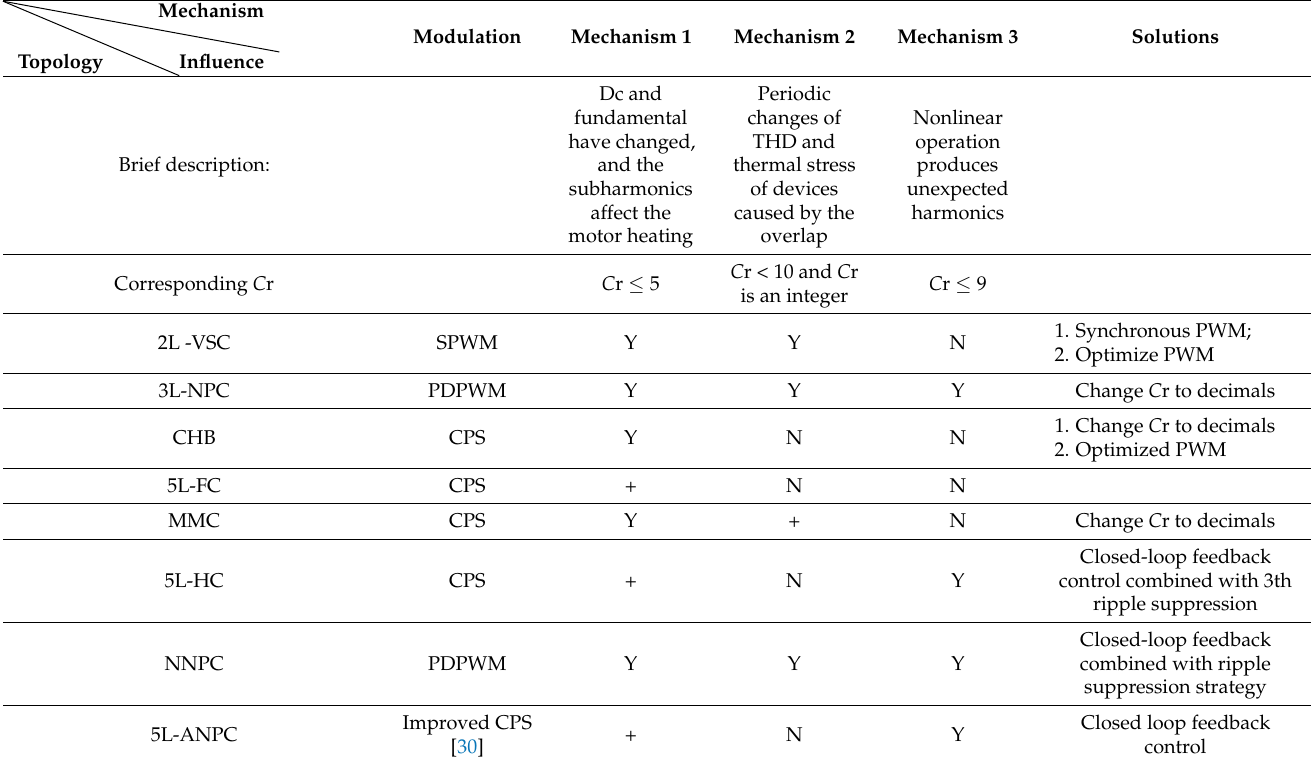
Table 5. Influences and solutions of the three harmonic overlap mechanisms in typical